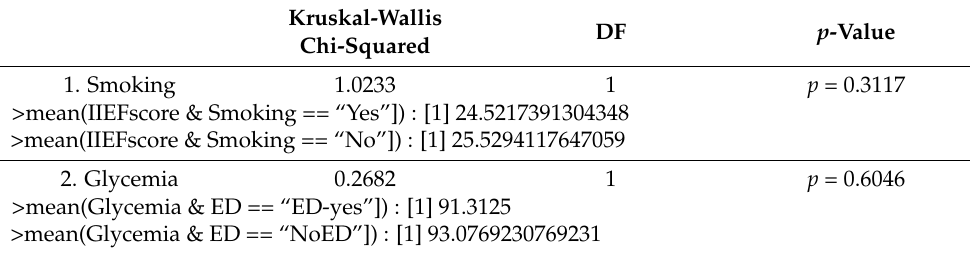
Figure 4. IIEF score (erectile function) distribution related to smoking. Figure 5. Glycemia related to erectile function.